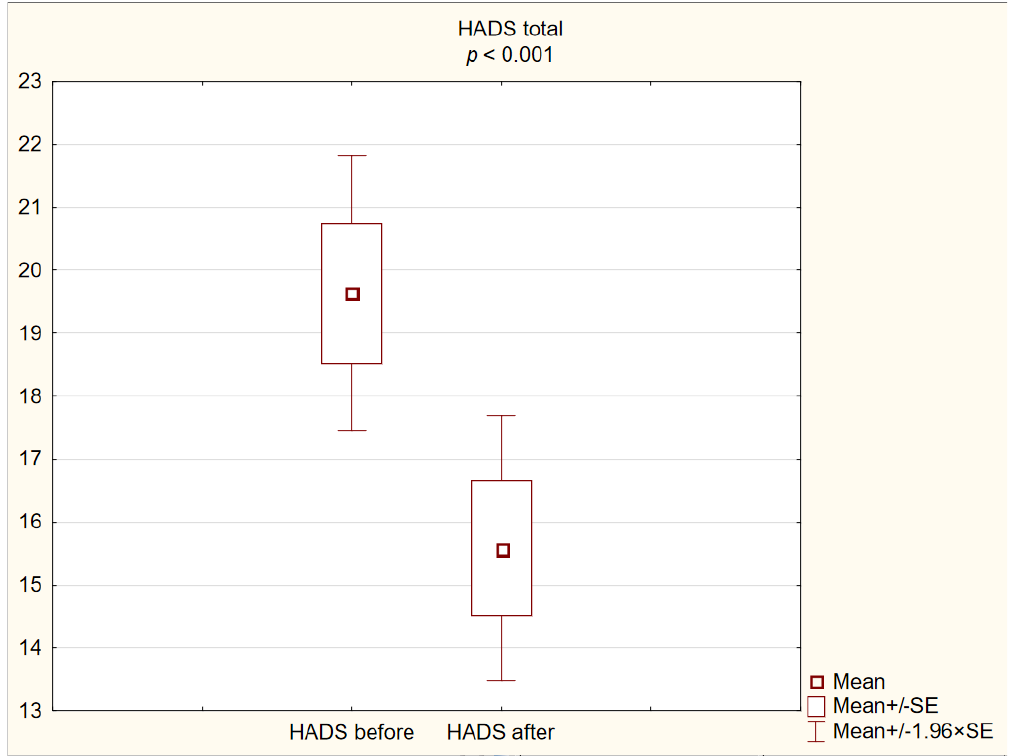
Figure 2. HADS score before and after completion of the rehabilitation program, Student ’’ s t-test.